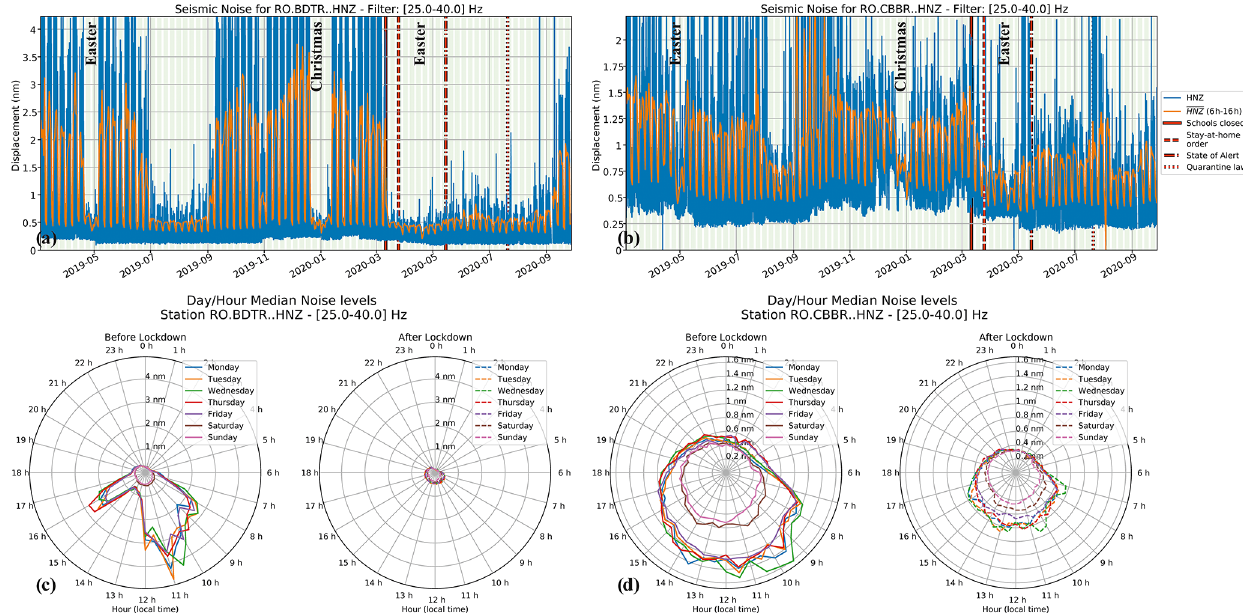
Figure 7. Temporal changes in seismic noise at a kindergarten in Bucharest (BDTR) (a) and the university in Cluj-Napoca (CBBR) (b) . The lower row shows 24h clock plots that give the average displacement variation for each day of the week and for the period before and during lockdown at (c) BDTR and (d) CBBR stations. The locations of the stations are displayed in Fig. 1.